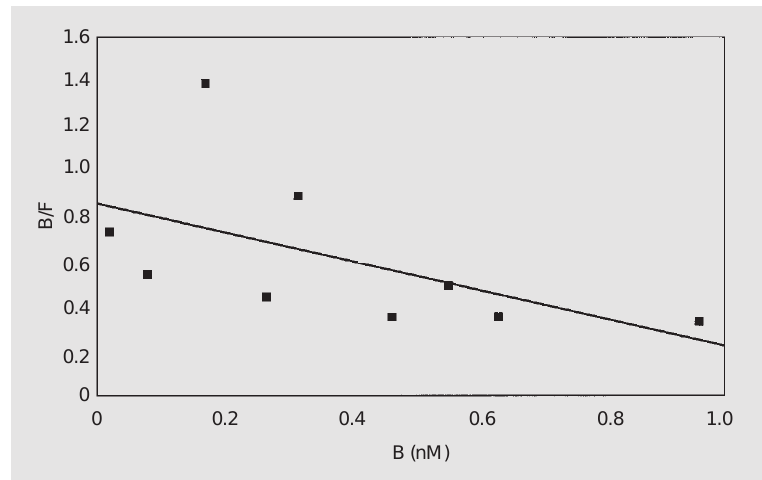
triangles).Figure 2 - Determination of mAb 6D1.1 affinity for CEA. Scatchard plot analysis obtained from binding of increasing amounts of 125 I-CEA to mAb 6D1.1-coated wells. The calculated affinity constant ( Ka ) was 0.63 ± 0.11 x 10 9 M -1